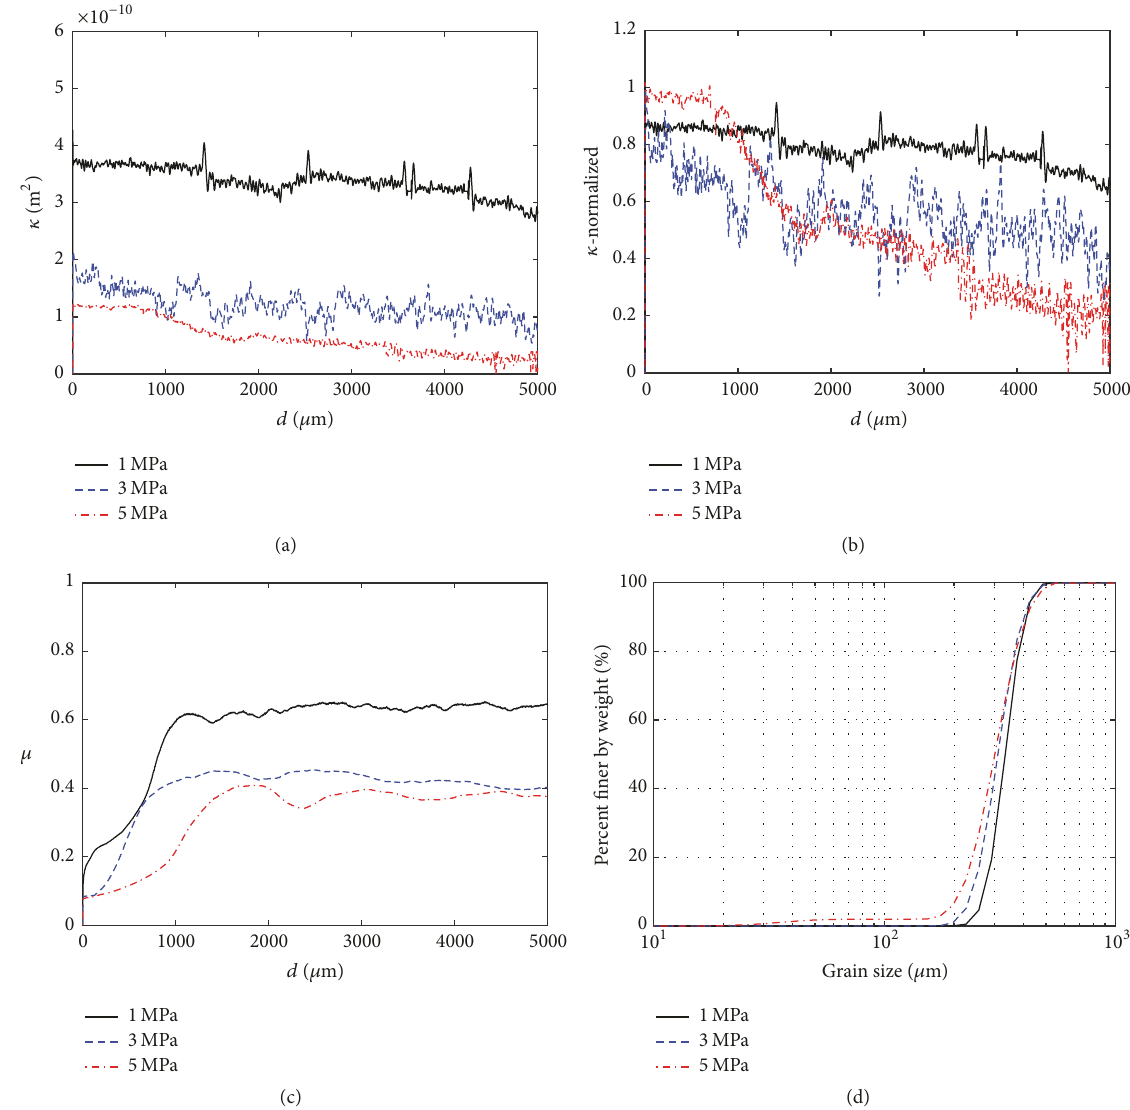
Figure 6: Evolution of (a) permeability, (b) normalized permeability (with respect to the initial permeability value), and (c) friction for the propped fracture during shearing under three different normal stresses of 1MPa, 3MPa, and 5MPa with displacement; (d) particle size distributions of proppants after experiments: at 1 MPa, grain size distribution before and after testing does not change much; thus the distribution at 1MPa is representative of the virgin particle distribution (i.e., 40/80